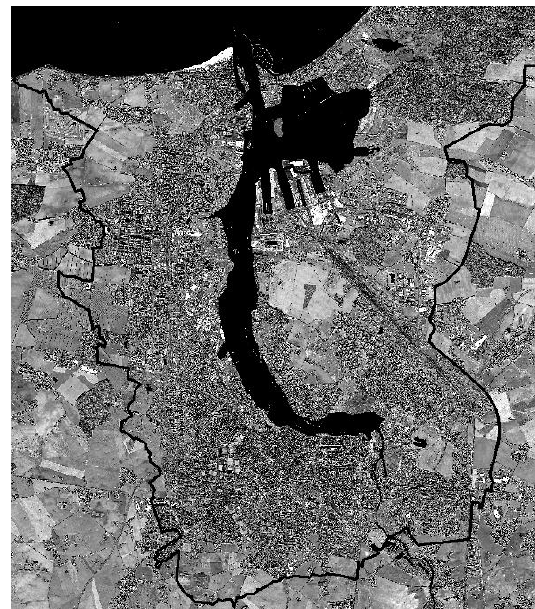
Figure 1: Quickbird satellite image with superimposed borders of Rostock ( c (cid:13) DigitalGlobe, Inc.,